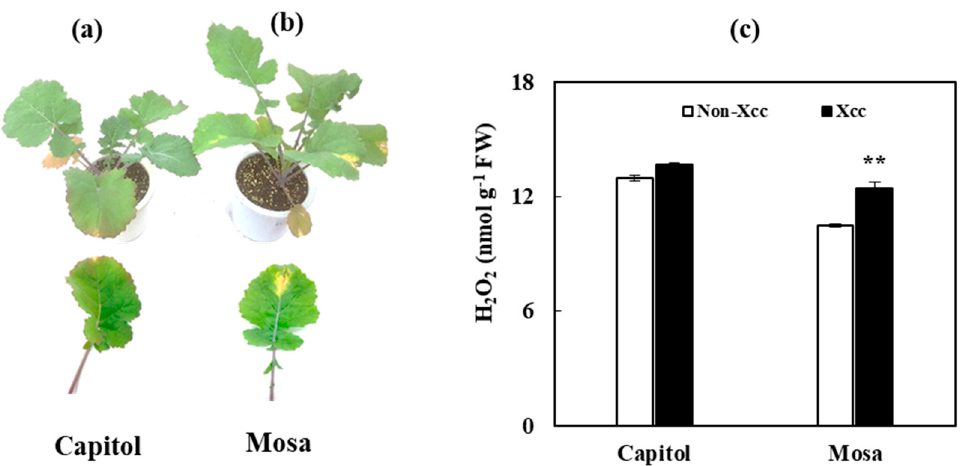
Figure 1. V-shaped necrotic lesion in the leaf of B. napus cultivars ( a ) cv. Capitol, ( b ) cv. Mosa and ( c ) H 2 O 2 content in response Table S3. Asterisks indicate significant differences between the noninoculated Xanthomonas campestris pv. campestris (Xcc) (control) and Xcc-inoculated plants; ** p < 0.01.